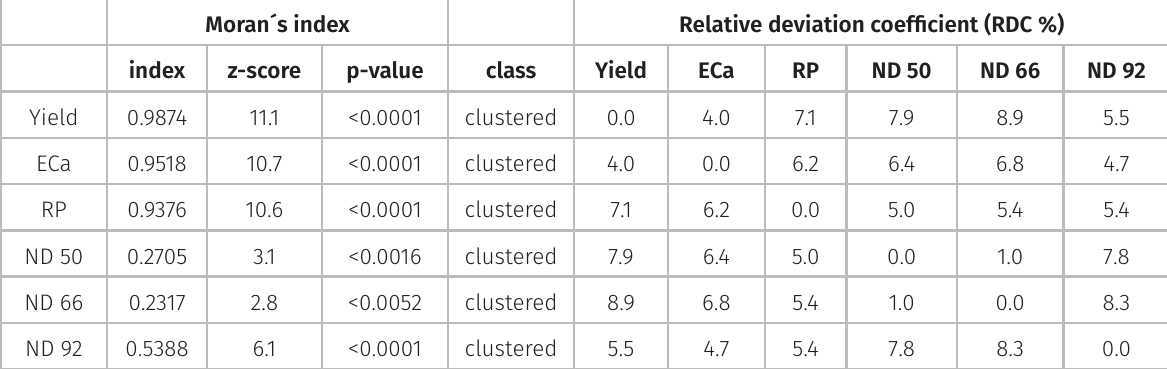
Figure 5. Spatial variability of grain yield (a), NDVI at 66 DAE (b), and soil mechanical resistance to penetration (c) measured at 0.4-0.6 m soil Table IV. Spatial autocorrelation (Moran´s index) and similarities between maps by the relative deviation coefficient (RDC %) to the variables yield, apparent electrical conductivity (ECa), soil resistance to the penetration (RP) and NDVI at 50, 66 and 92 DAE (ND).